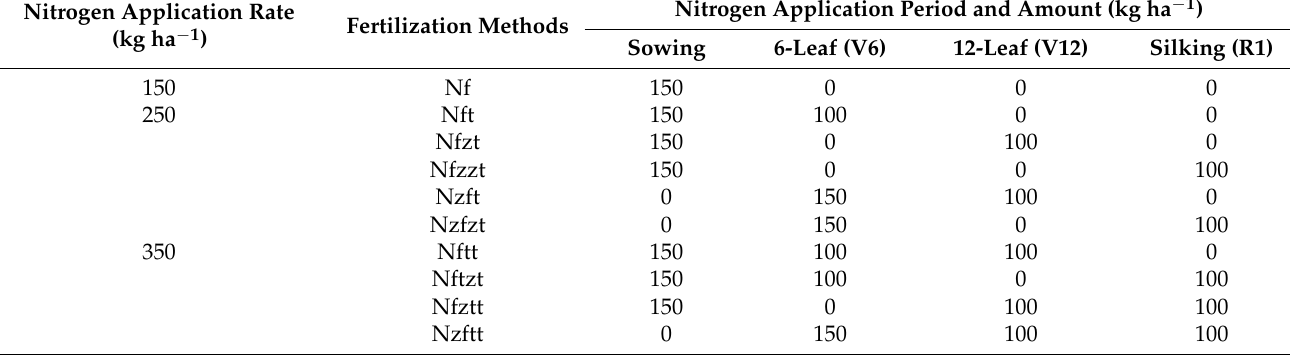
Table 2. Fertilization methods and period under different nitrogen application